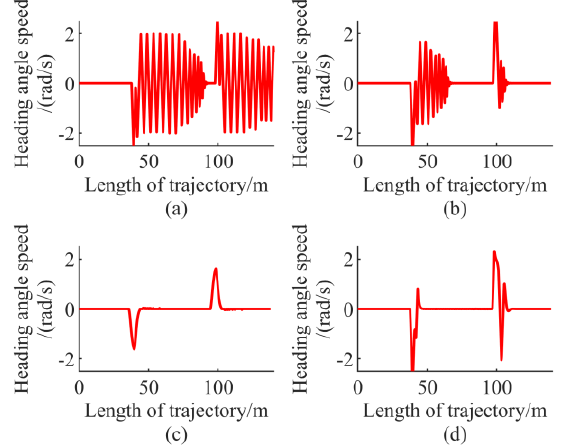
Figure 23. The heading angle speed when parameters changed. ( a ) LMPC. ( b ) LEMPC. ( c ) NMPC. ( d ) NEMPC.